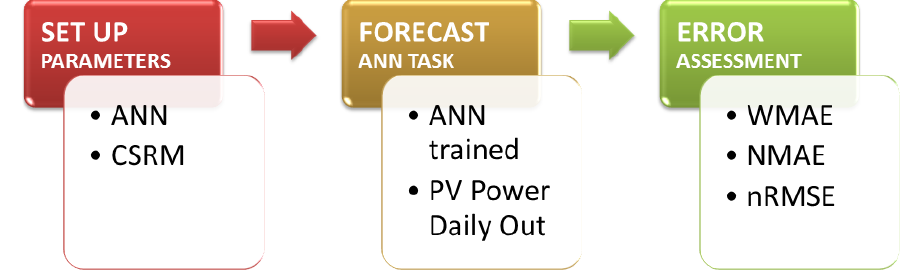
Figure 1. Block diagram of the PHANN